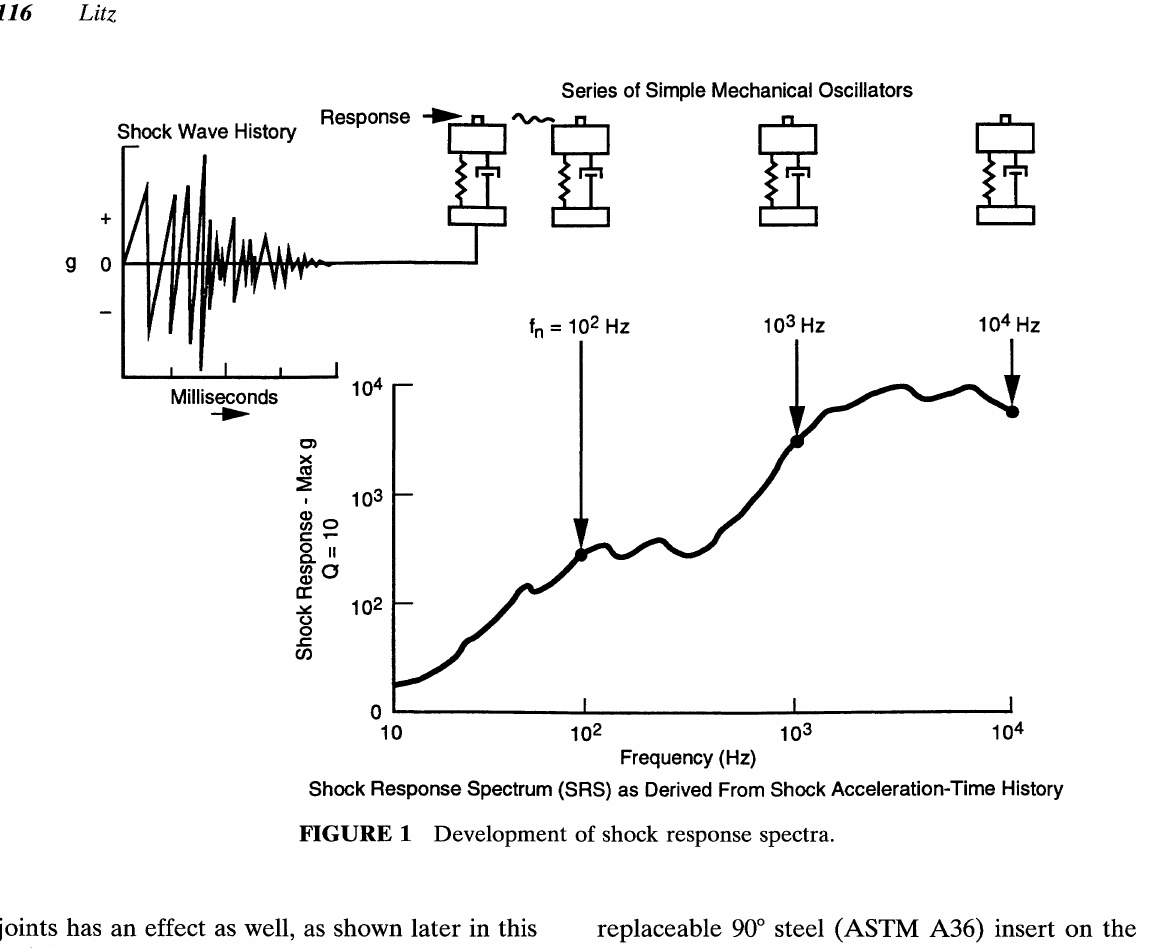
FIGURE 1 Development of shock response